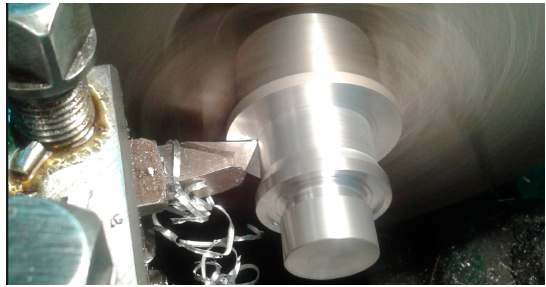
Figure 3. Cilindrical lathe of the semi-couple